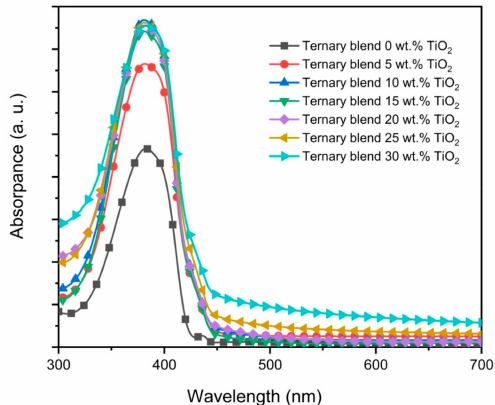
Figure 5. Absorbance spectra of PFO / 0.5 wt.% F8BT / 0.3 wt.% MEH-PPV films without and with TiO 2